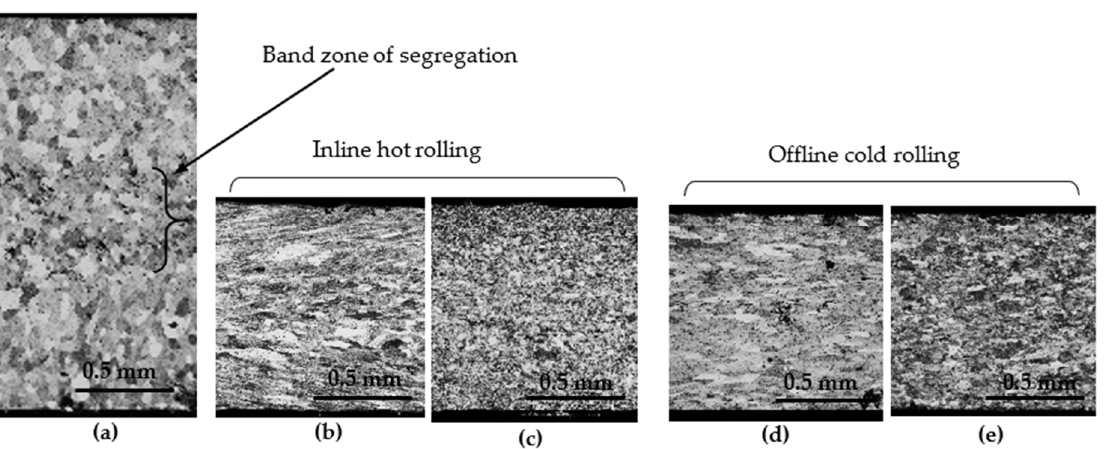
Figure 19. Microstructures of as-cast strip, inline hot rolled strip and offline cold-rolled strip. ( a ) as-cast strip, ( b ) inline hot-rolled 1 mm-thick strip, ( c ) after annealing of inline hot-rolled strip, ( d ) offline cold-rolled 1-mm-thick strip, and ( e ) after annealing of offline cold-rolled strip. Aluminum alloy: Al-4.8%Mg, Roll diameter: 300 mm (upper) and 1000 mm (lower), Roll width: 100 mm, Roll speed: 60 m/min, Solidification length: 100 mm, Roll load: 13 N/mm.